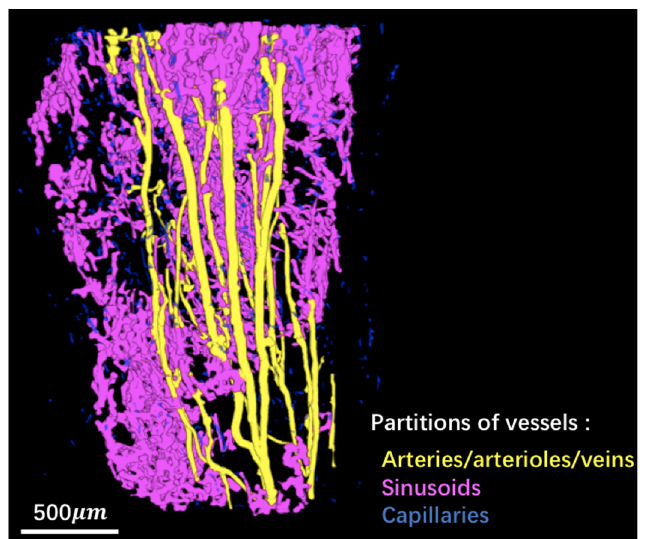
Figure 3. Partitions of blood vessels: arteries/arterioles/veins (yellow), sinusoids (magenta), and capillaries (blue).